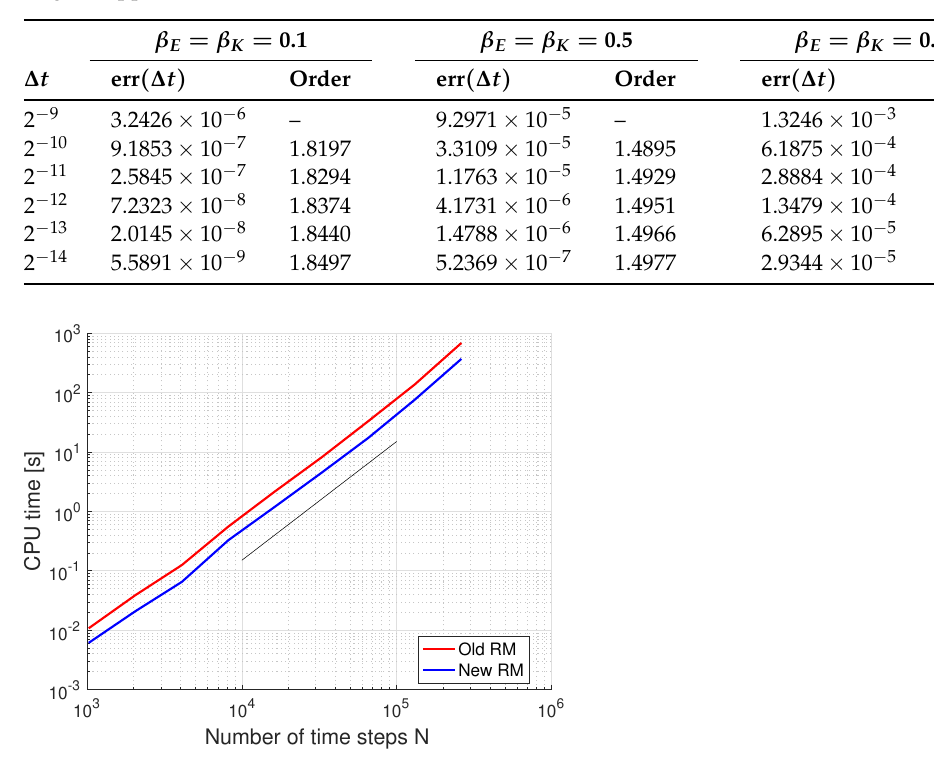
Table 1. Convergence behavior for the return-mapping Algorithm 1 obtained in this work and the original approach from [14] for an FVEP device with an SB element.